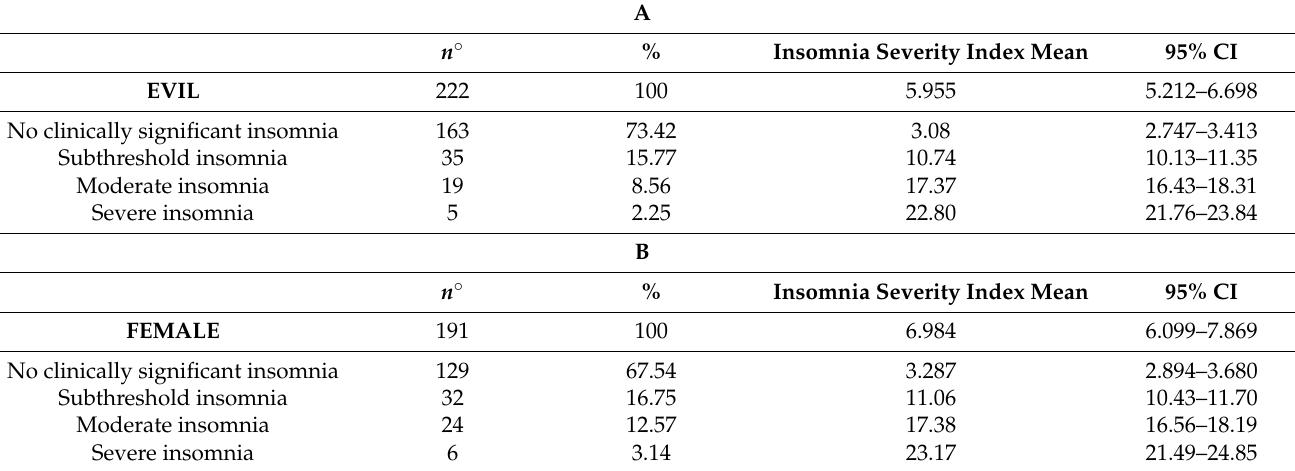
Table 1. Data on the presence or absence and degree of insomnia in male (A) and female (B) subjects. A n ◦